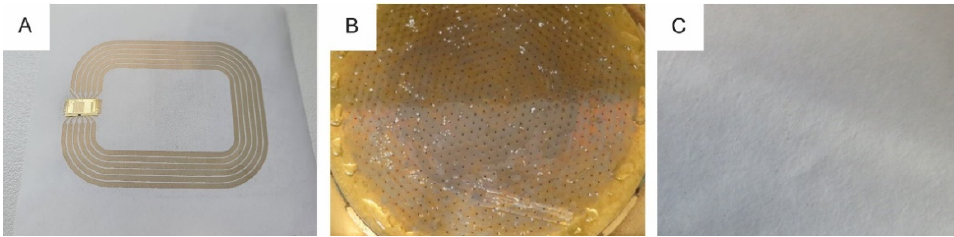
Figure 13. Screen printed RFID antenna with integrated IGZO-TFT microchip ( A ), 0.7 mm hole reject ( B ) and sheet adhesion test results ( C ) of functional screen printed RFID antennas with ‘Loctite ECI 1011 ′ ink and integrated microchips on Magno Satin substrate.